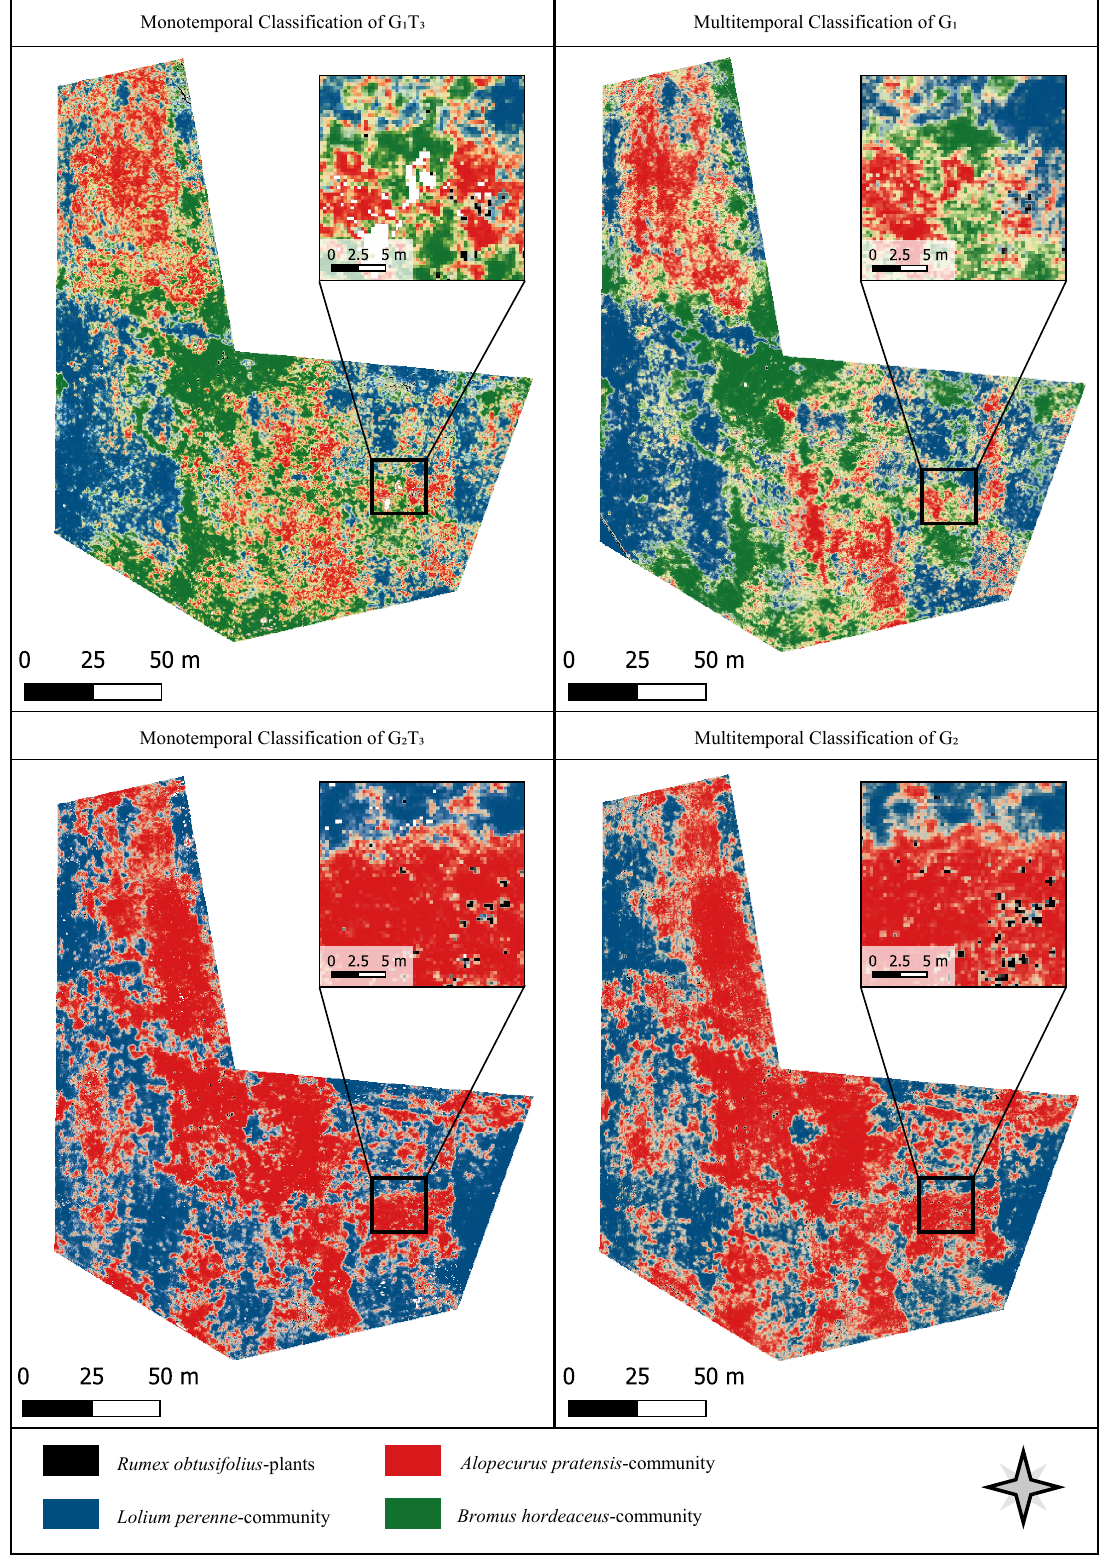
Figure 4. Subsets of the classification results of the mono- and multitemporal model and orthomosaics in RGB-color of G 1 T 3 and G 2 T 3